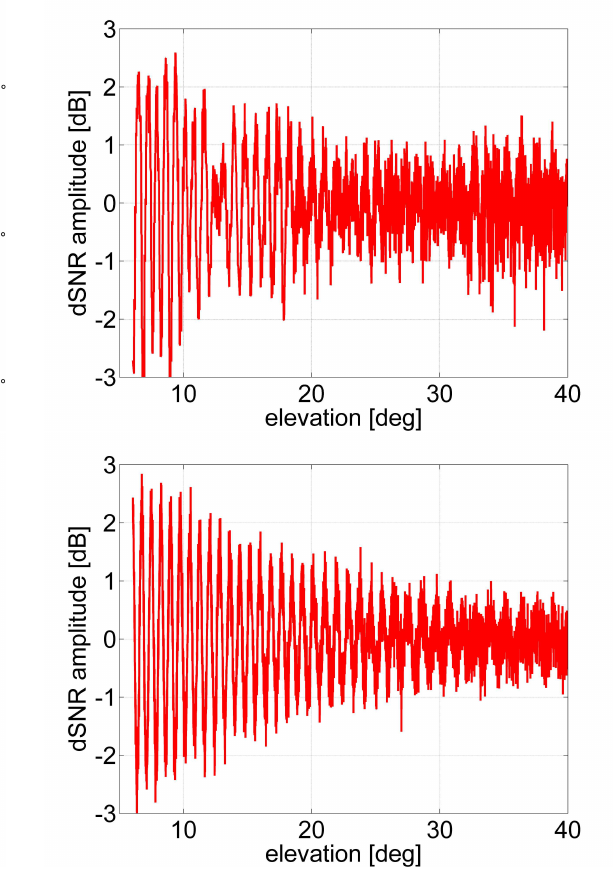
Figure 4: dSNR data of GPS satellite 1: original data (top), simulated data